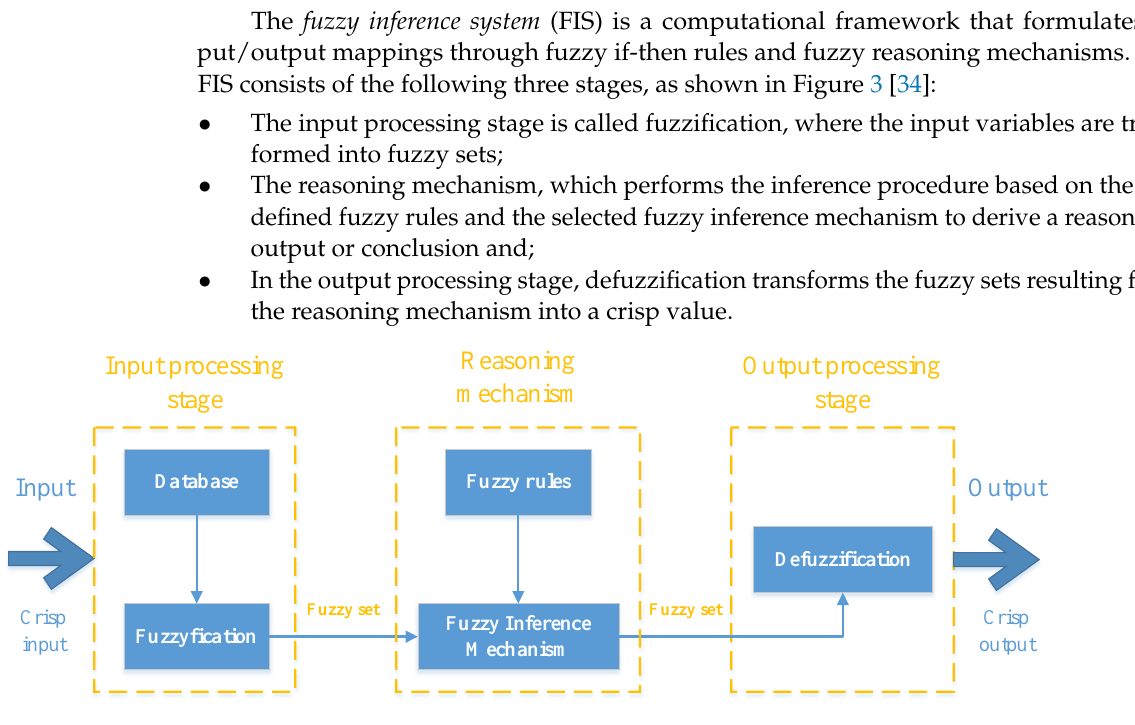
Figure 4. Structure of the Mamdani fuzzy inference system (adapted from [34]).